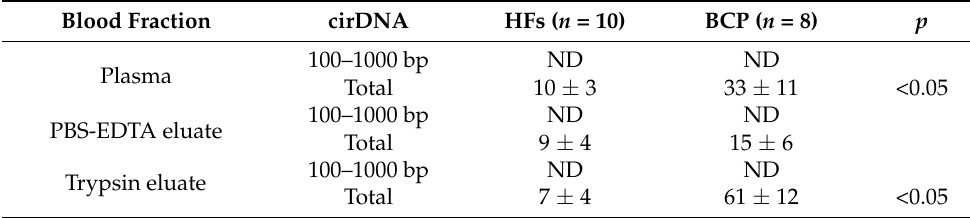
Table 1. RAR β 2 index of methylation in the cirDNA from HFs and BCPs, mean ± SD *. Blood Fraction cirDNA Plasma PBS-EDTA eluate